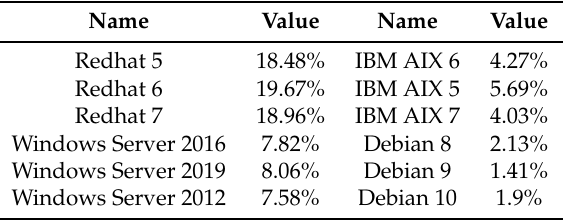
Table 1. Distribution of operating systems.